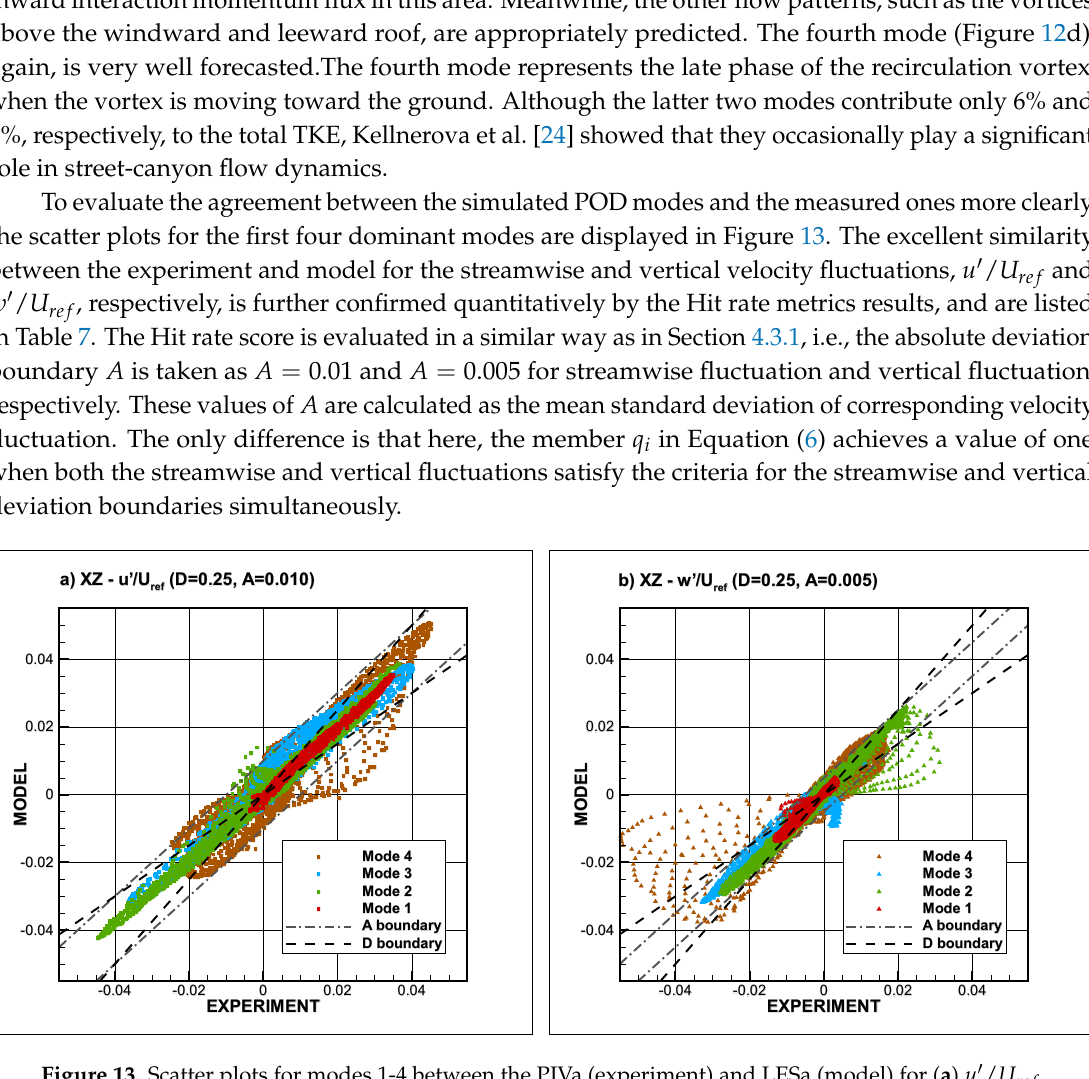
Figure 13. Scatter plots for modes 1-4 between the PIVa (experiment) and LESa (model) for ( a ) u (cid:48) / U ref and ( b ) w (cid:48) / U ref . Table 7. Hit rate metric q for POD